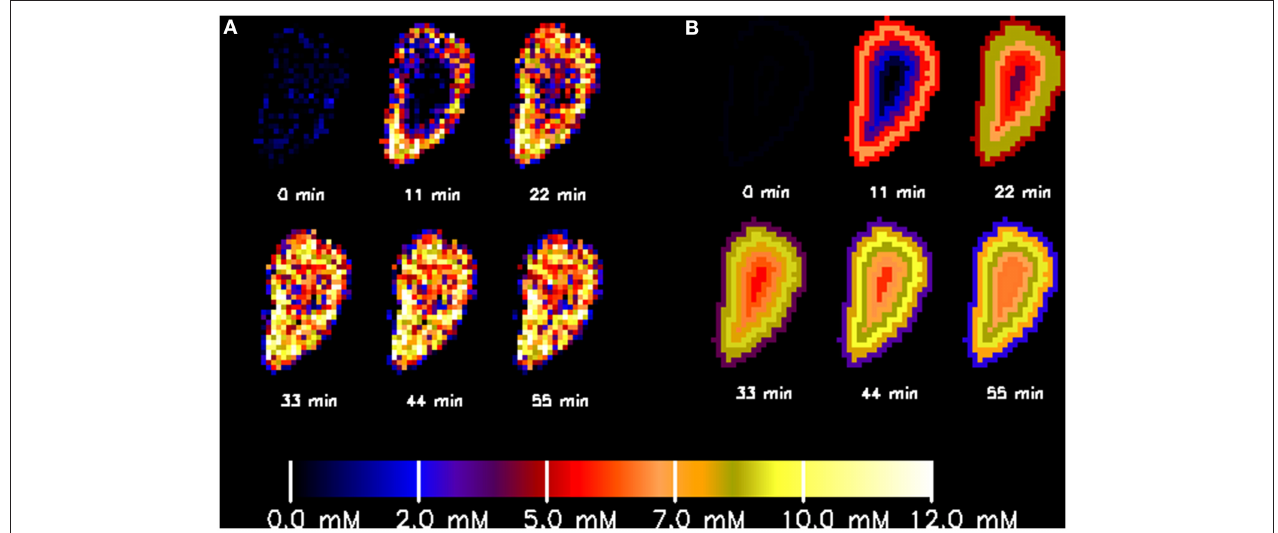
FIGURE 6 | Spatially resolved increase of cobalt concentration inside a single methanogenic granule upon injection of a 5mmol · L − 1 CoCl 2 solution at time zero as obtained by calculation at each single voxel (A) or averaged over layers of specific depths inside the granule (B).